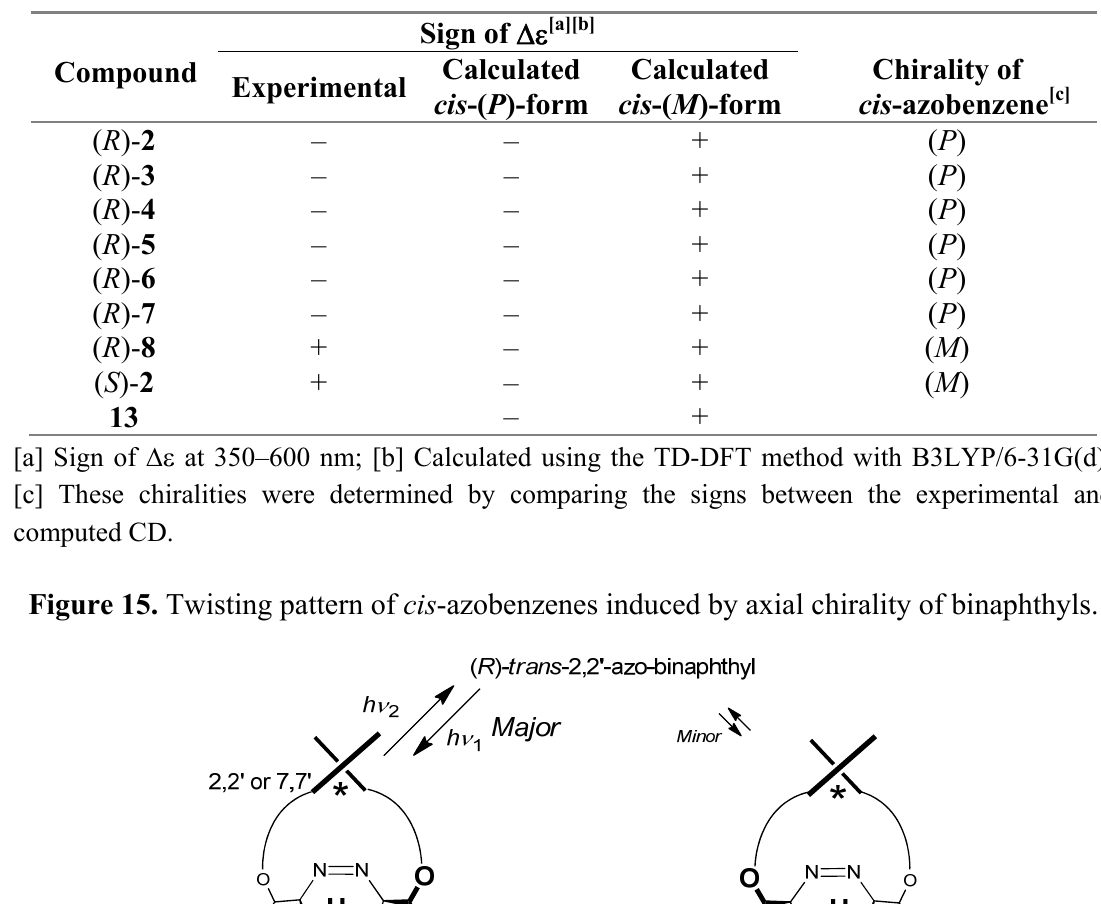
Table 4. Sign of experimental and calculated CD, and helical chirality of the cis - azobenzene moiety in 2 – 8 and 13 .